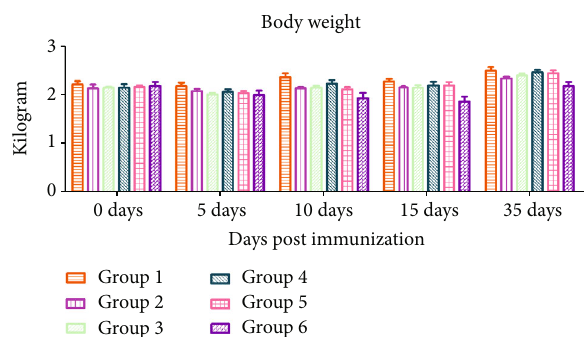
Figure 3: The body weight of rabbits in Experiment A was measured before and after immunization on Days 0, 5, 10, 15, and